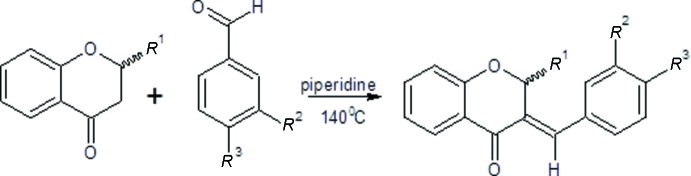
Scheme of the synthesis of compounds I and II. R
1 = H/Ph, R
2 = H/OH, R
3 = OH/H, respectively for compound I and II.